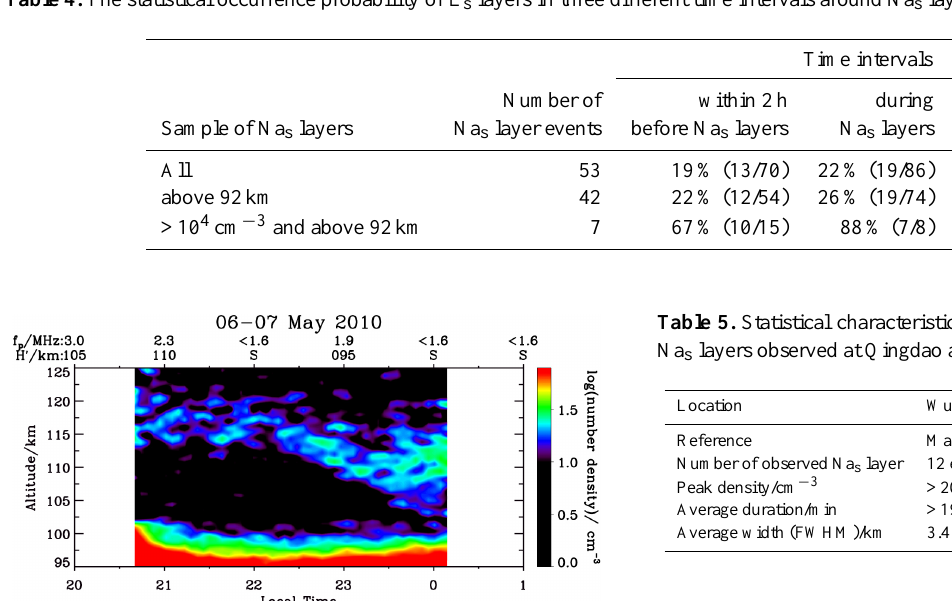
Table 4. The statistical occurrence probability of E s layers in three different time intervals around Na s layers.